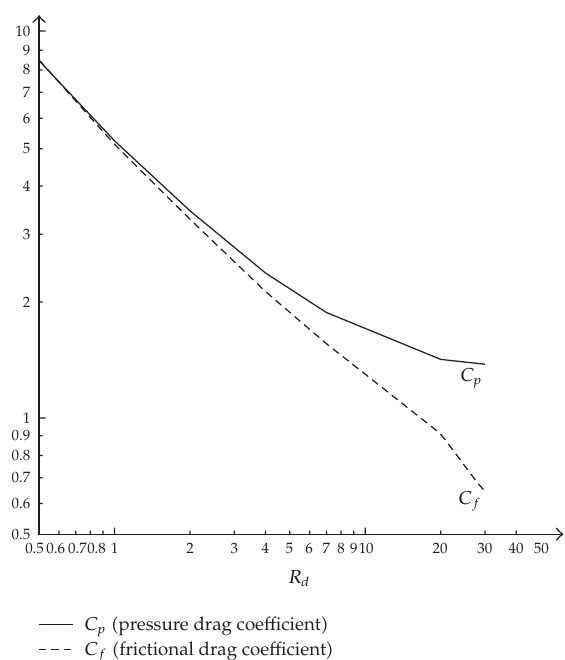
Figure 2: Drag coe ffi cient as a function of R d